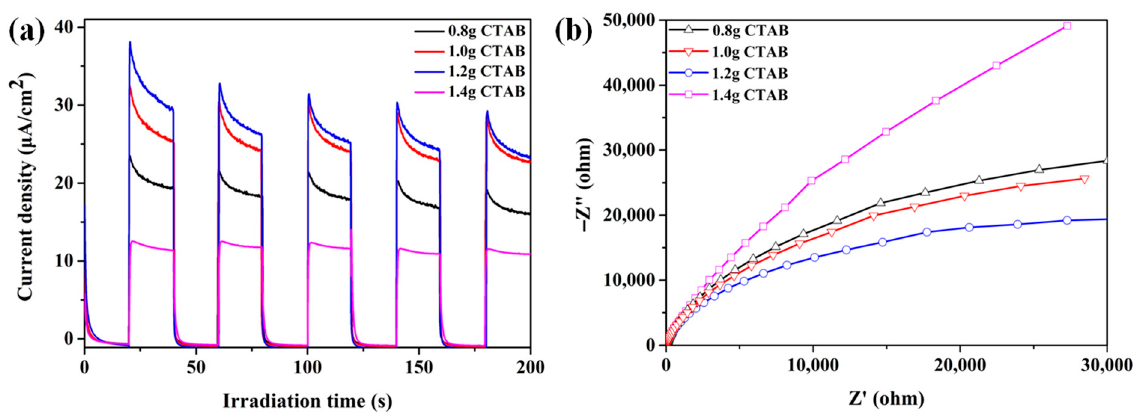
Figure 8. ( a ) The transient photocurrent response curves and ( b ) EIS Nyquist plots of ZnO particles synthesized with different amounts of CTAB.